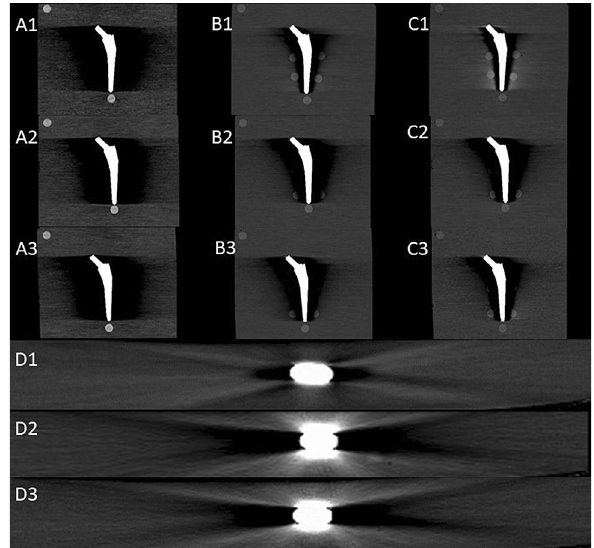
Figure 2. CT images of metal implants show metal artefact reduction with increasing energies 40 keV ( A ), 100 keV ( B ) and 190 keV ( C ). The grade of artefact reduction is similar with chrome-cobalt (2) and stainless steel (3) but increased with titanium (1). The transversal reconstructions (190 keV) on mid-stem level illustrate alloy-dependent dark and bright streak artefacts ( D ). The density of reference pellet 1 (left upper corner) is decreasing with rising energy.